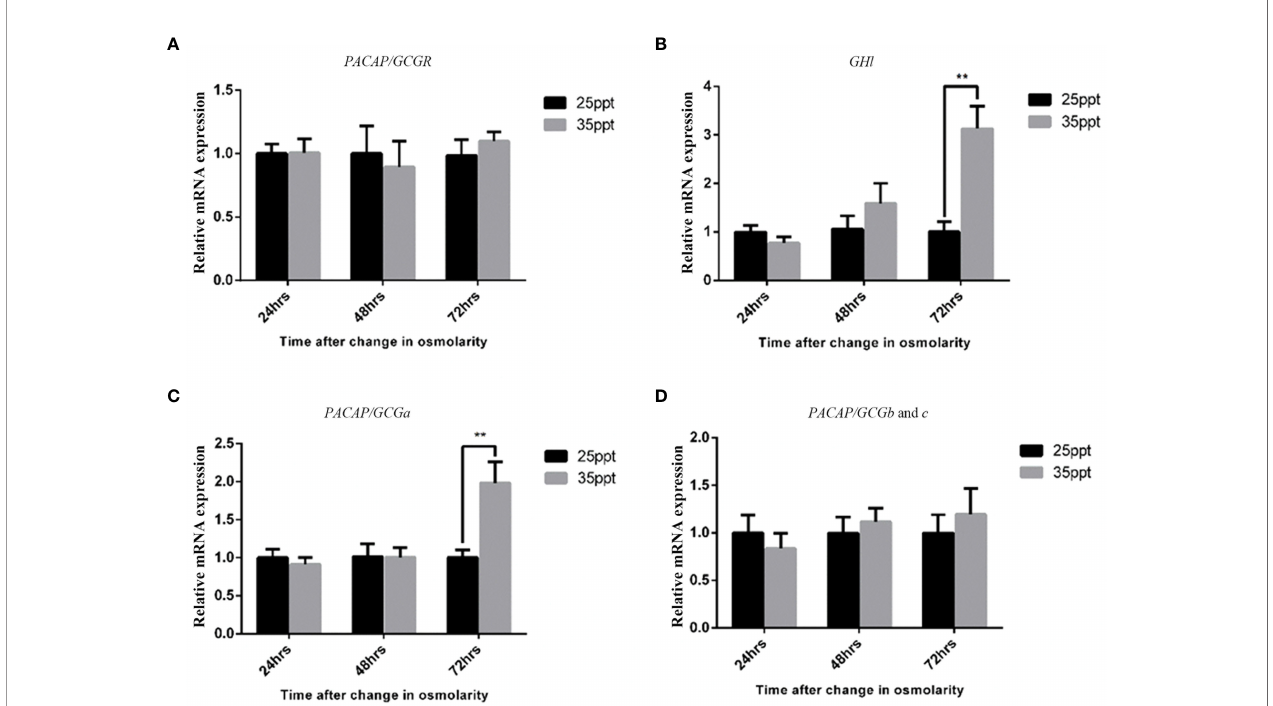
FIGURE 6 | Effect of high salinity challenge in the expression of the PACAP/GCG system and GHl in the head of B . belcheri . Gene expression levels of (A) PACAP/ GCG-R , (B) GHl, (C) PACAP/GCGa , and (D) PACAP/GCGb and PACAP/GCGc determined by quantitative PCR and normalized using the ef1a expression as reference. Data represent the pool of samples collected from two independent experiments ( n = 3/experiment) and is expressed as means ± SEM ( n = 6 unpaired t -test, ** p ≤